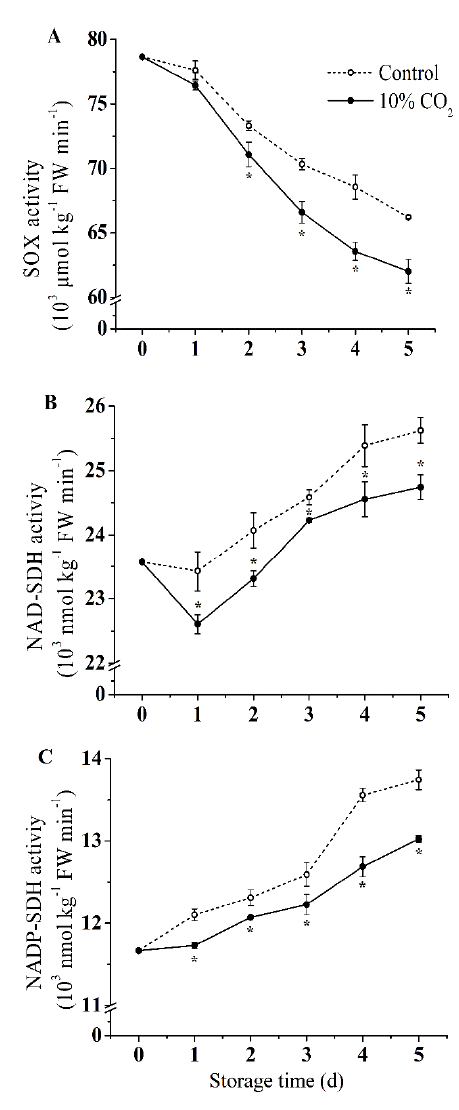
Figure4. E ff ectofCO 2 onactivitiesofSOX( A ),NAD-SDH( B ),andNADP-SDH( C )offresh-cutpearfruit during storage. Values are presented as means ± SD ( n = 9). Asterisks (*) indicate significant di ff erences at the same time between controls and CO 2 -treated fruit according to the Student’s-test ( p <